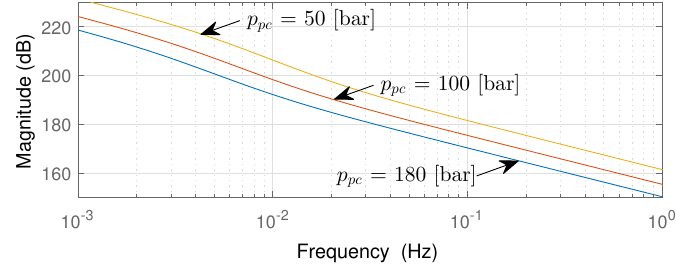
∆ P s ( s ) ∆ Q ( s ) for three levels of pre-charge pressure. The (cid:0) (cid:1) = ( p s 0 , ˙ V g 0 , T g 0 185 bar,10 L/min,22 ◦ C )